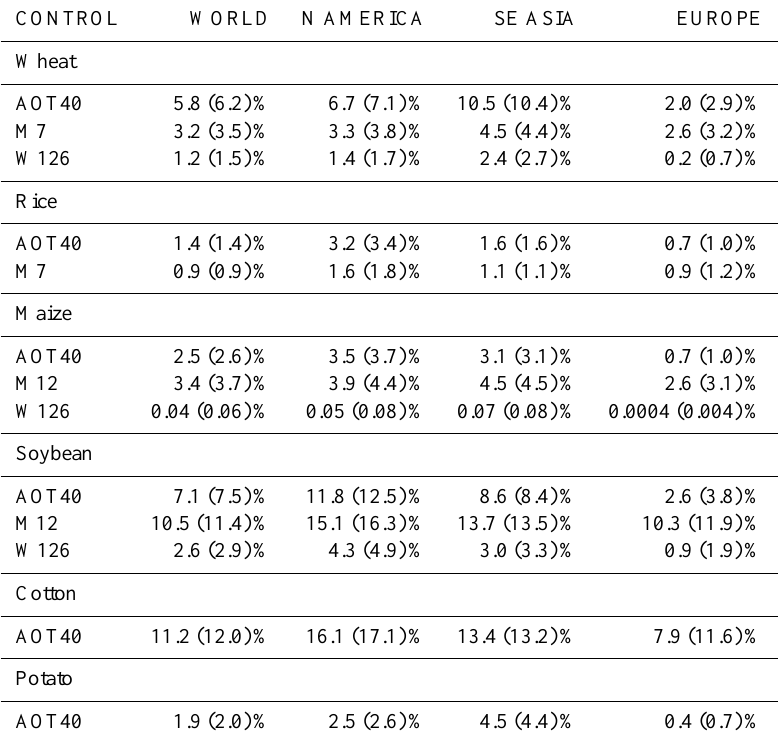
Table 4. Regionally-aggregated relative yield loss for the six crops under the model control scenario. M7 and M12 exposure response relationships are not available for potato and cotton. For these crops only yield losses based on AOT40 are presented. For W126 yield losses are shown for wheat, maize and soybean only. Values in brackets show bias-corrected results (see text for